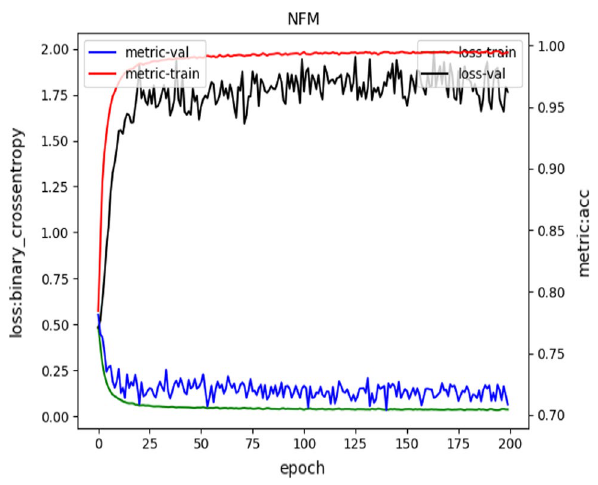
Fig. 7 AUC and Logloss of NFM